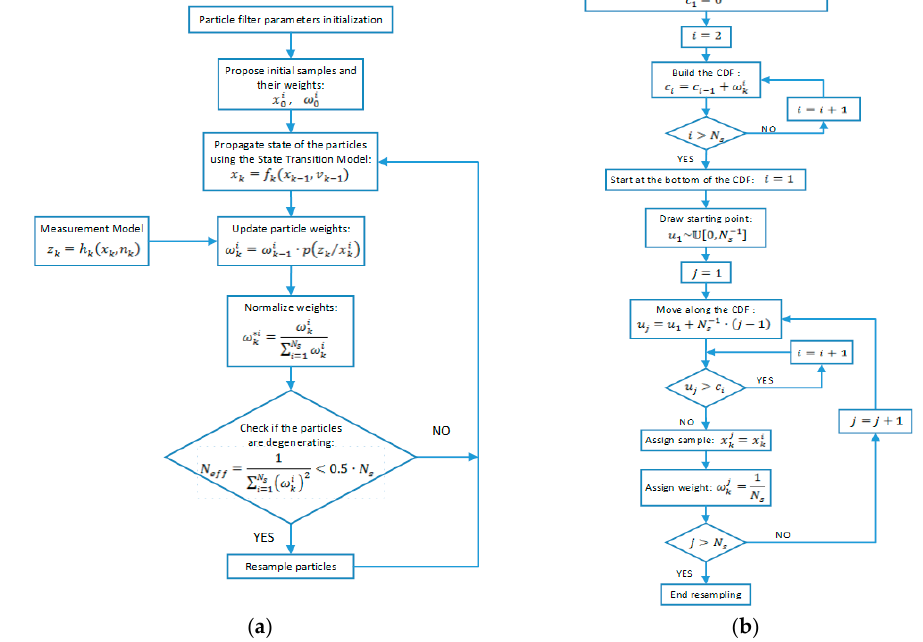
Figure 3. ( a ) Particle filter algorithm methodology; ( b ) re-sampling strategy.